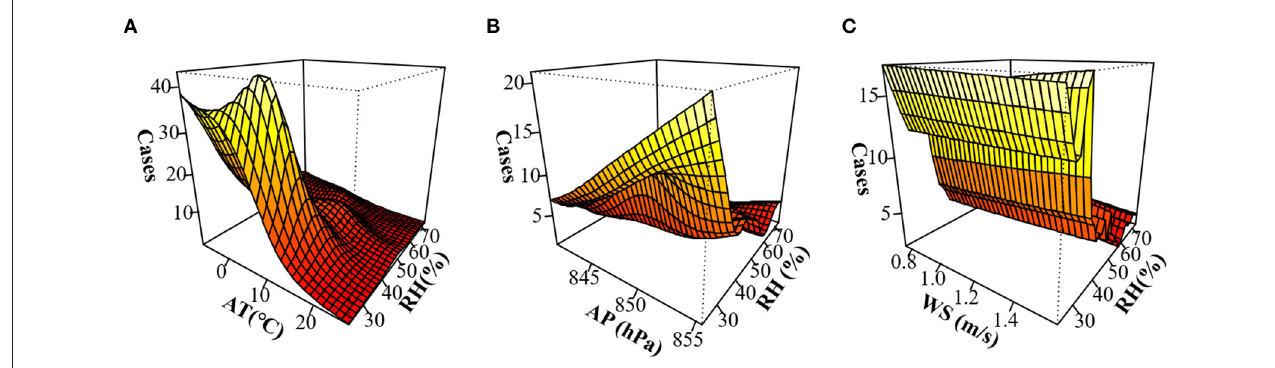
FIGURE 4 | Three-dimensional map of the interaction effect of relative humidity (RH) with other meteorological parameters on influenza incidence in Lanzhou, China during 2010–2019 after a lag of 3 weeks. (A) Interaction effect of RH with AT. (B) Interaction effect of RH with AP. (C) Interaction effect of RH with WS.